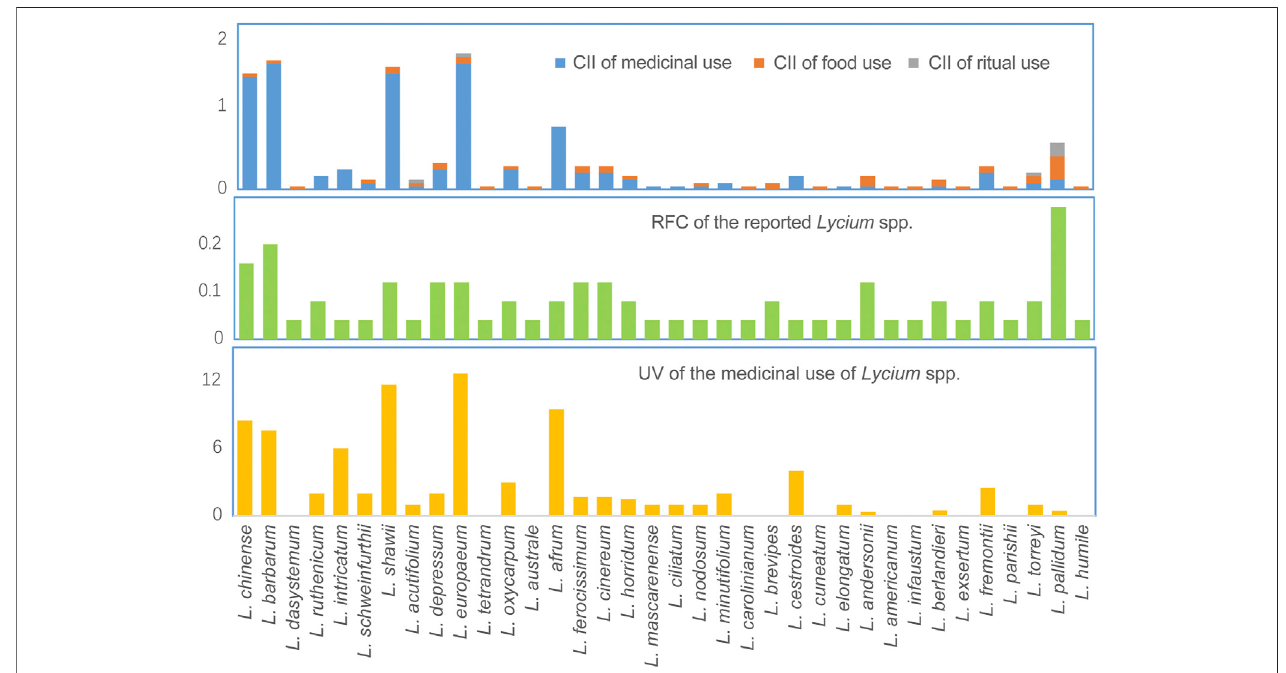
FIGURE 3 | Cultural Importance Index (CII) and Relative Frequency of Citation (RFC) of Lycium spp., and Useful Value (UV) of their medicinal uses.